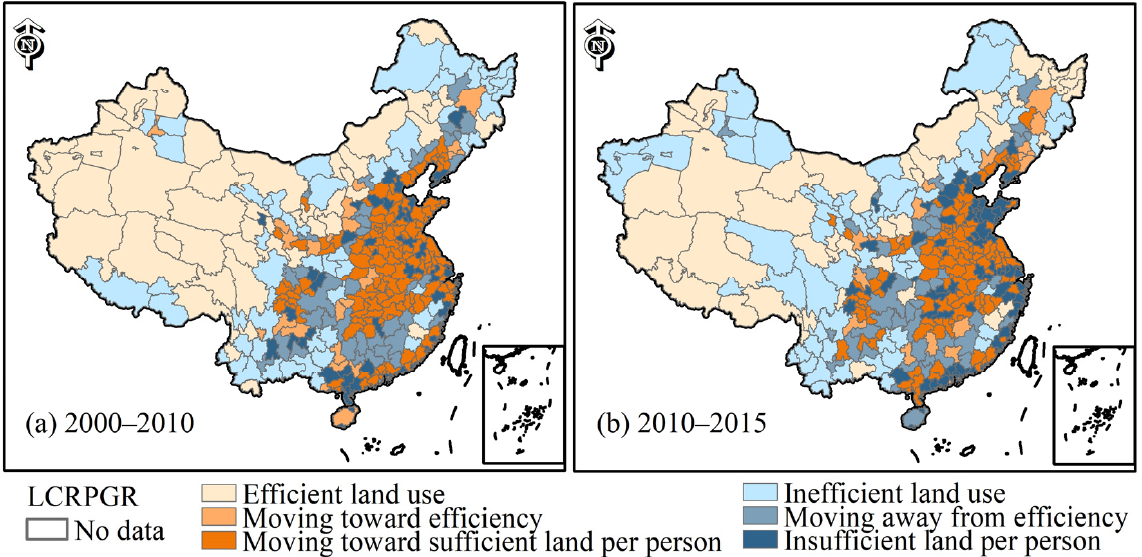
Figure 8. The spatial distribution of the ratio of land consumption to population growth rate (each polygon shape (city) is attached with a color, which represents the city’s LCRPGR type).